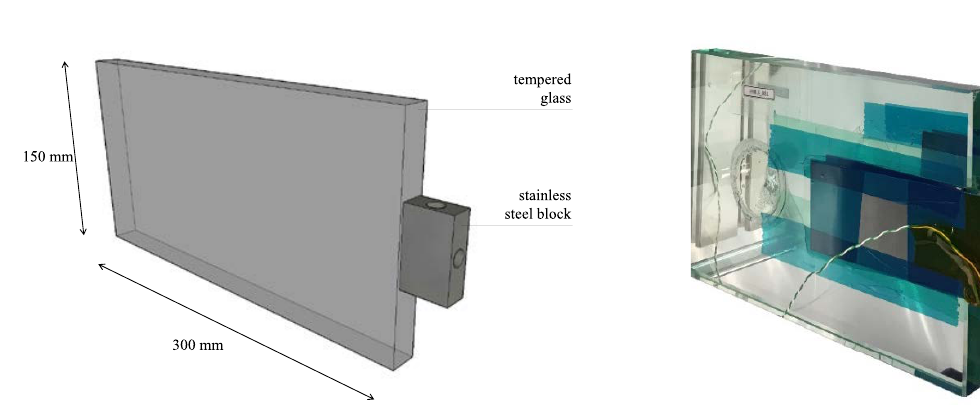
Fig. 1 Glass specimen with stainless steel block bonded to the edge Fig. 2 Edge-laminated connection during fabrication